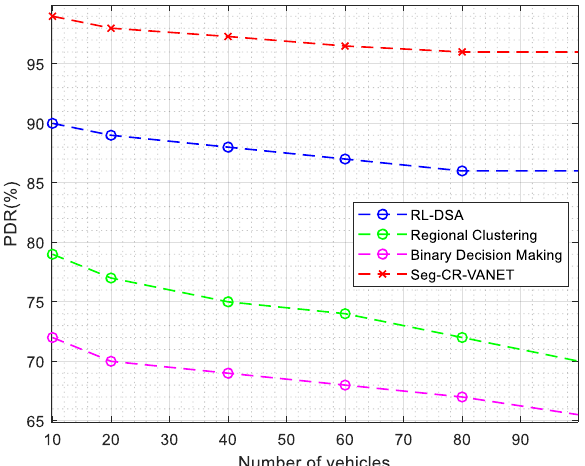
Figure 11. Comparison of packet delivery ratio (PDR).